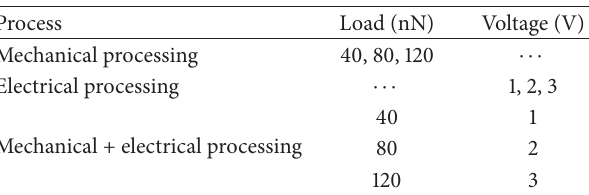
Table 1: Processing